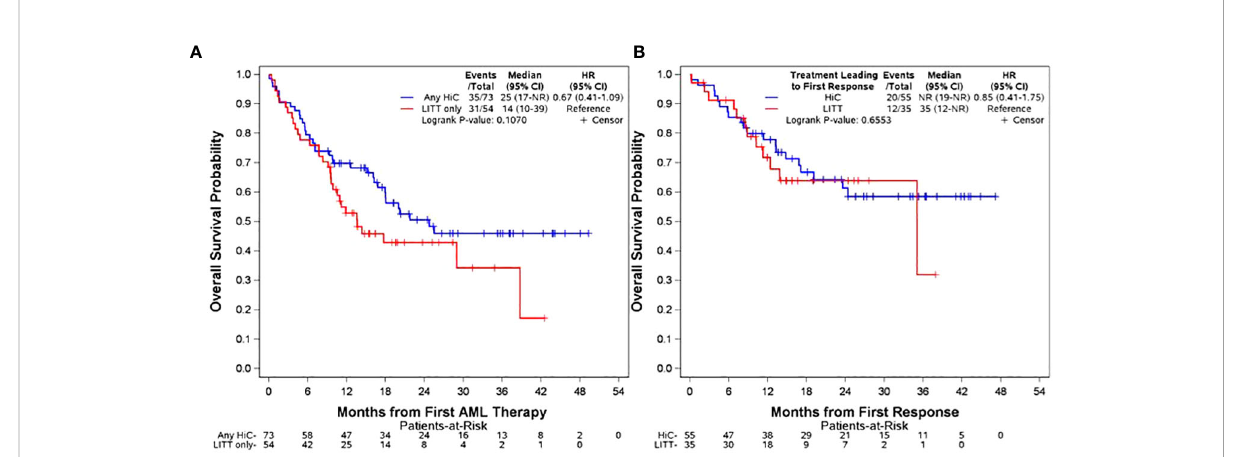
FIGURE 1 Overall Survival Panel (A) : OS from date of treatment initiation strati fi ed by any HiC vs. LITT only. Panel (B) OS from date of fi rst response strati fi ed by treatment leading to fi rst response (HiC vs. LITT). The distributions were estimated for each treatment group with the use of the Kaplan-Meier method and were compared with the log-rank test. The hazard ratio for death was estimated with the use of the Cox proportional-hazards